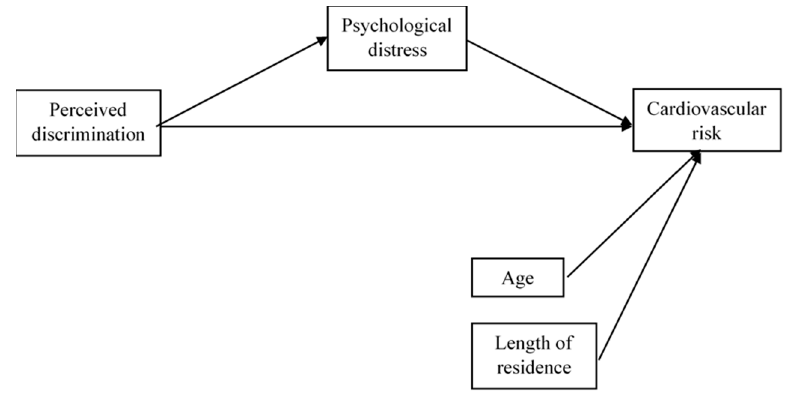
Figure 1. Path model.